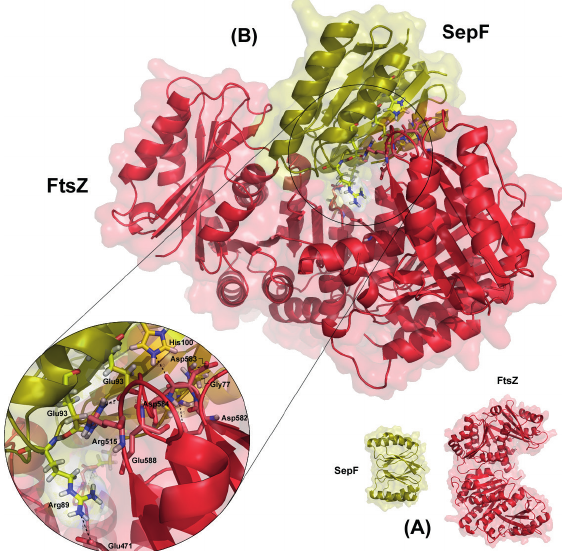
Figure 3 - Protein-Protein docking of FstZ and SepF. (A) The proteins structures before the docking process. (B) The in-silico docking from FtsZ (1RLU) and SepF (3ZIH) highlighting the amino acids involved in the